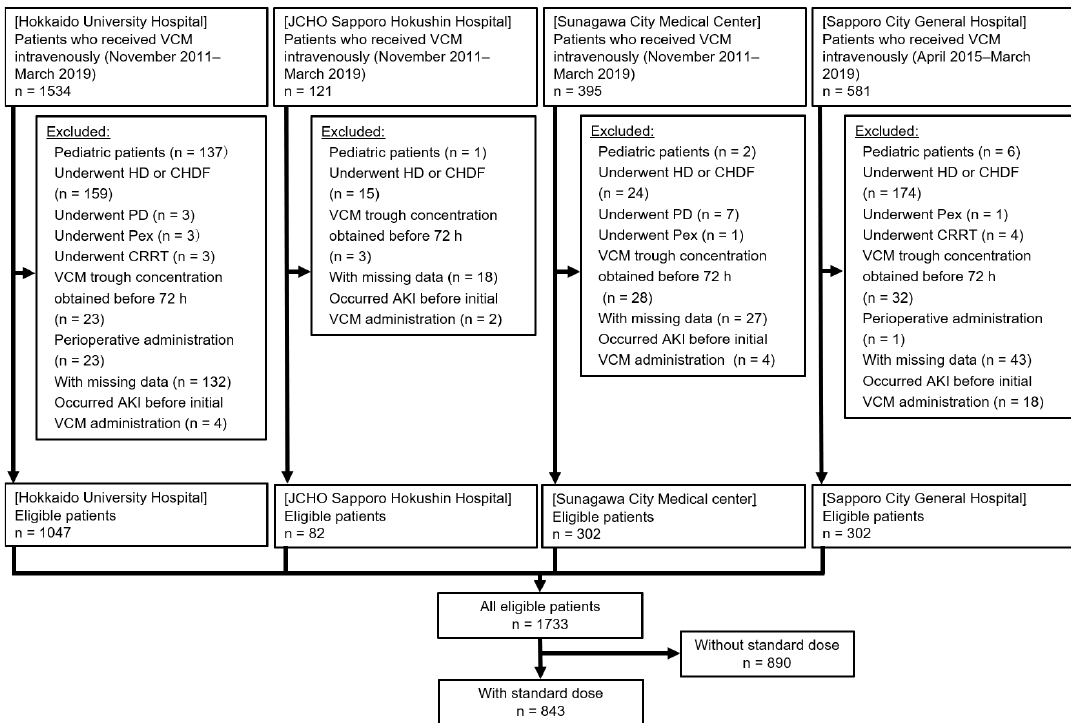
Figure 1. Flowchart of patients included in this study. The standard dose was defined within the recommended dose ± 250 mg in reference to Thomson et al.’s study [21] (Table 3) (for example, in patients with creatinine clearance > 110, Thomson et al. recommended 1500 mg every 12 h, whereas we defined the standard dose as 2500–3500 mg per day). Abbreviations: JCHO, Japan Community Healthcare Organization; VCM, vancomycin; HD, hemodialysis; CHDF, continuous hemodiafiltration; PD, peritoneal dialysis; Pex, plasma exchange; CRRT, continuous renal replacement therapy; AKI, acute kidney